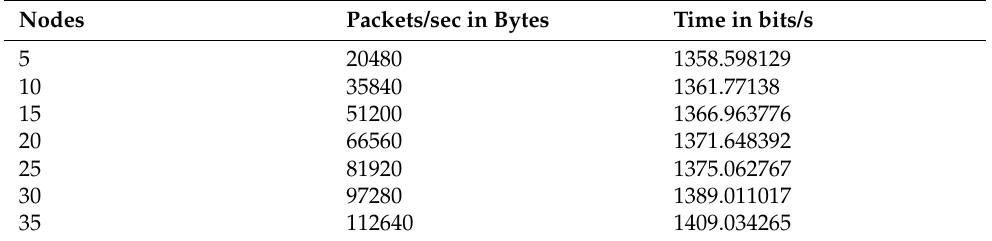
Table 5. Total transmission time for nodes using the Z-MAC scheme along with the IHOP mechanism.